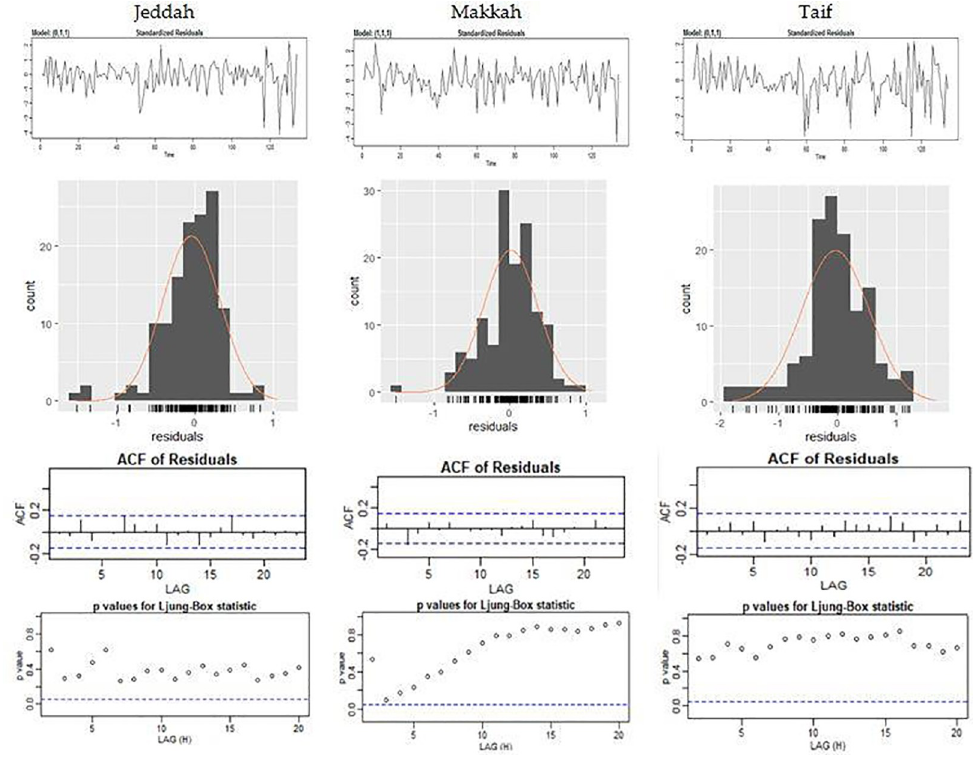
Fig 5. Residuals analysis plots of the three ARIMA